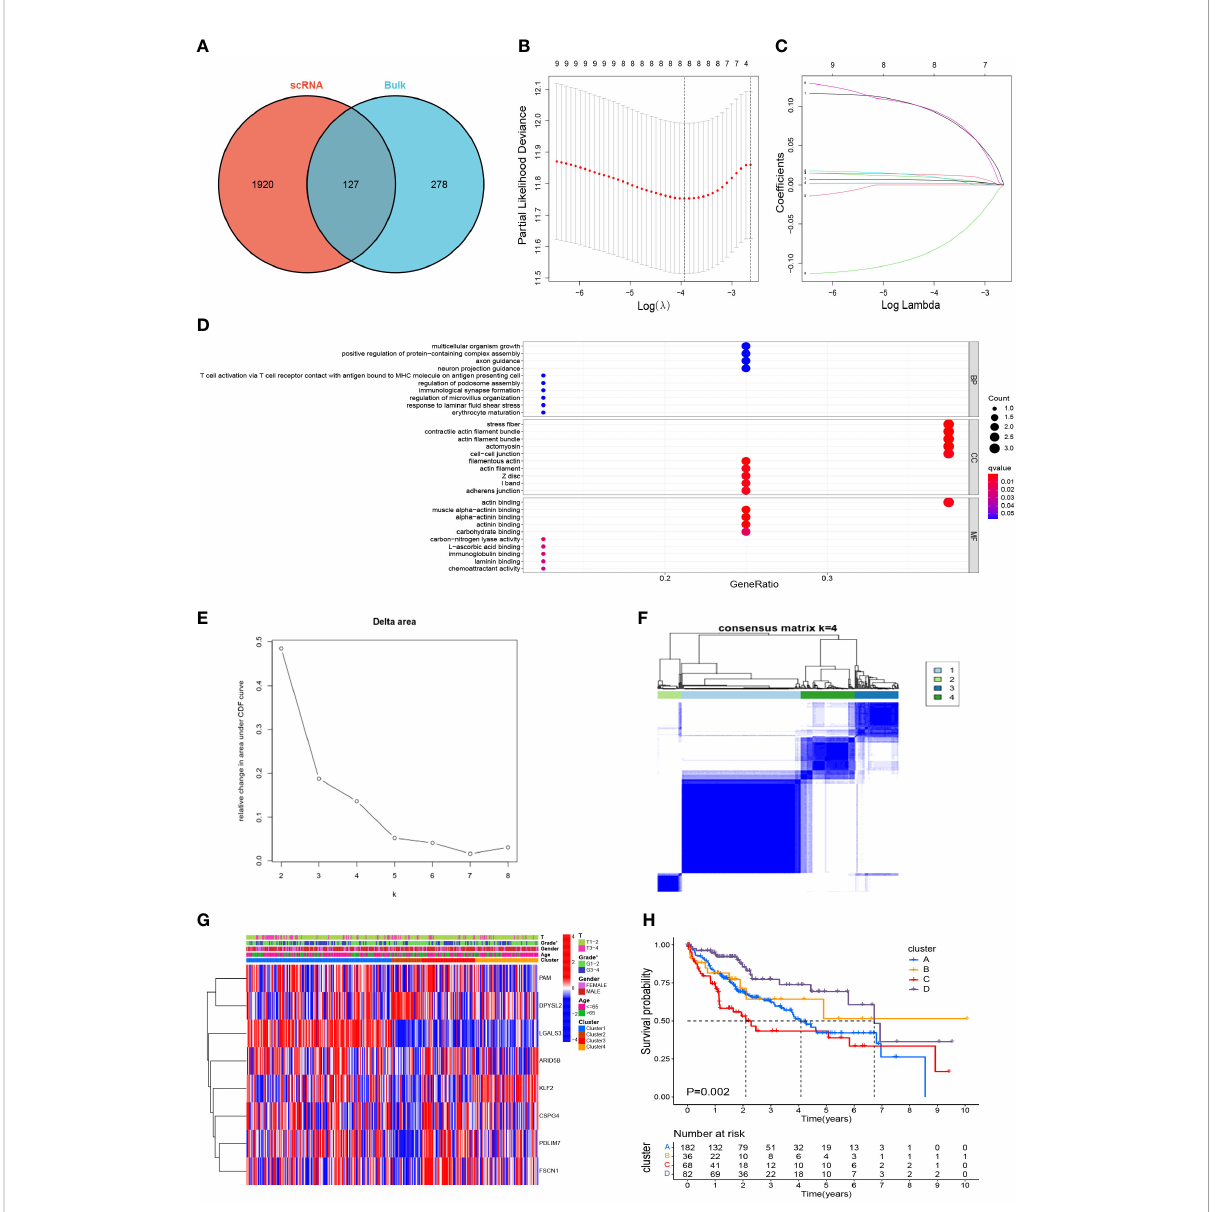
FIGURE 4 Screening of M2-likeTAM-related prognosticgenes and unsupervised consensus clustering. (A) Acquisition of candidate M2-like TAM-related genes. (B, C) lasso regression analysis to identify signature genes. (D) Enrichment analysis using the GO database. (E, F) Consensus clustering plot showing that 4 was the optimal k value and TCGA-LIHCsamples were classi fi ed into four clusters. (G) Heatmap demonstrated the differences in gene expression and clinicopathological characteristics among the fourclusters. (H) Kaplan – Meier survival curves revealed survival differences between the four clusters. *P<0.05. TAM, tumor-associated macrophage; lasso, least absolute shrinkage and selectionoperator; GO, gene